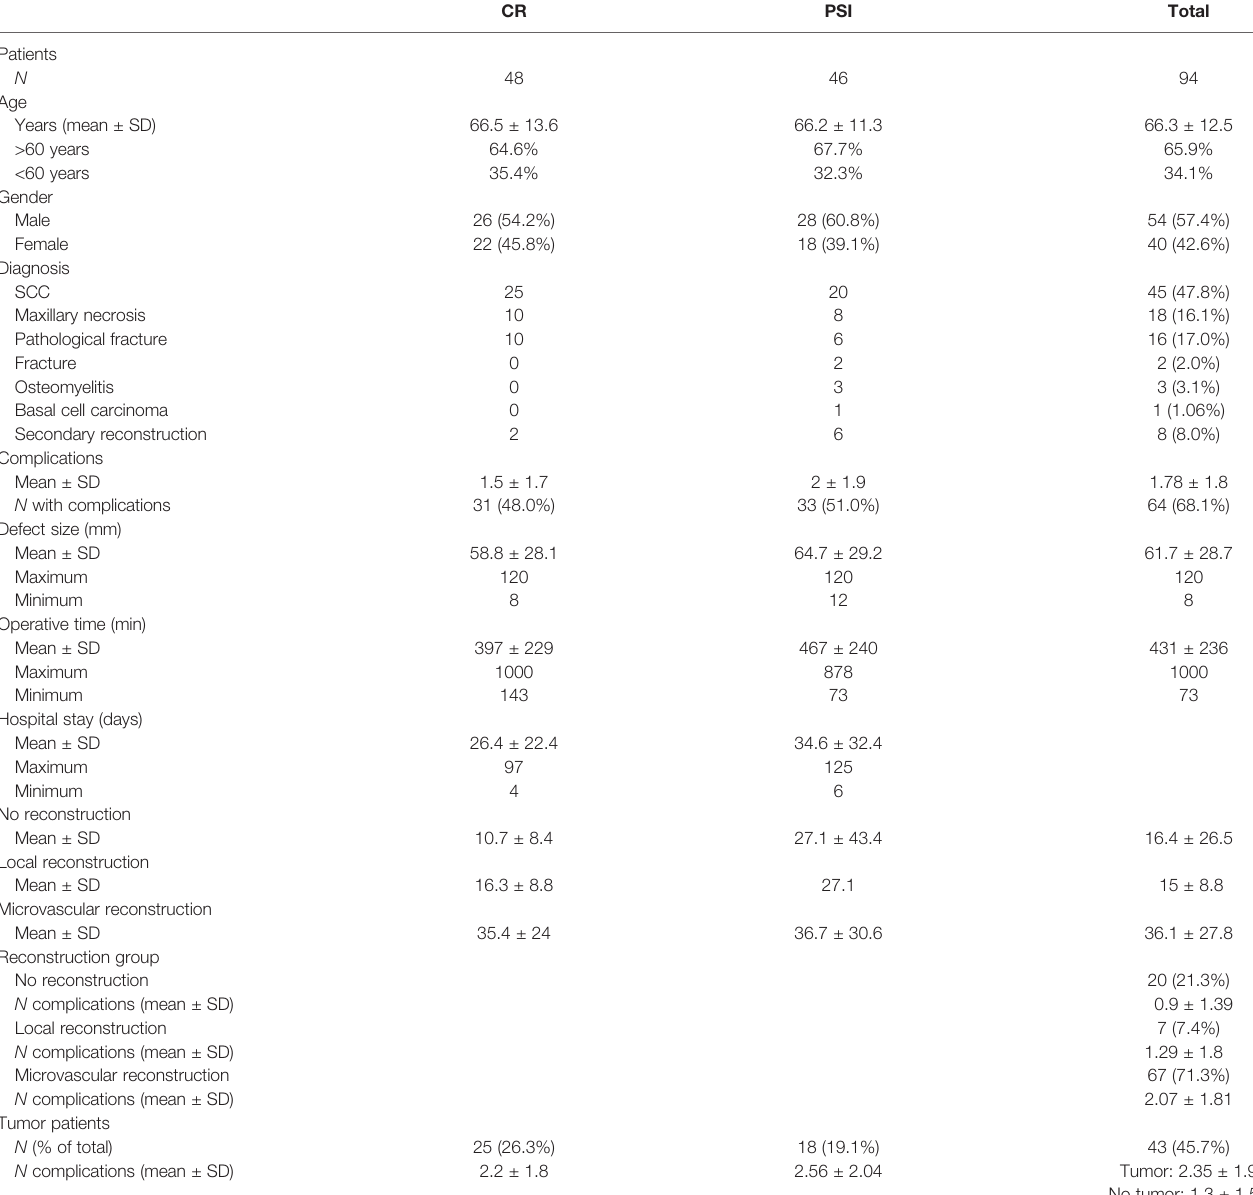
TABLE 1 | Descriptive statistics [conventional reconstruction plates (CR) vs . patient-speci fi c implants (PSI)].